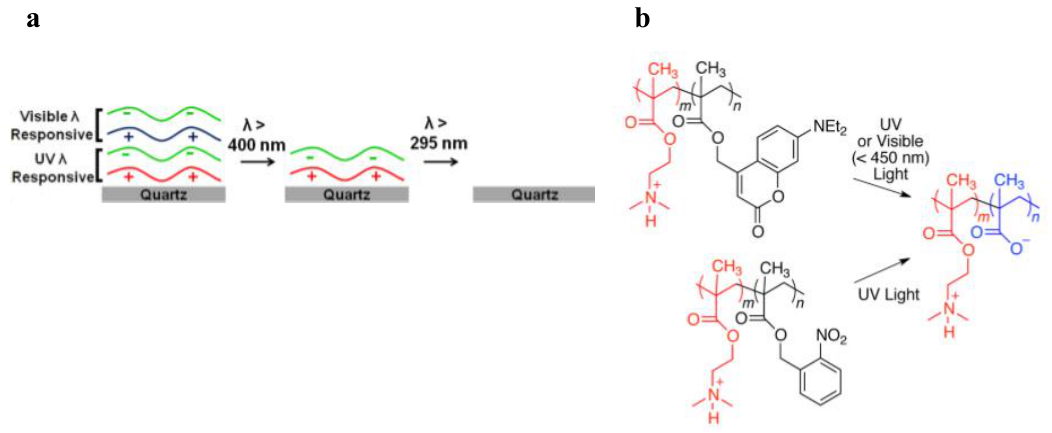
Figure 5. ( a ) Schematic illustration of the de-assembly process through different wavelength irradiations. ( b ) Design of photosensitive polycations that reduced net charge upon irradiation with either visible (coumarinyl groups) or UV (coumarinyl or nitrobenzyl groups) light (Reprinted with the permission from reference [55] Copyright 2014 American Chemical Society).